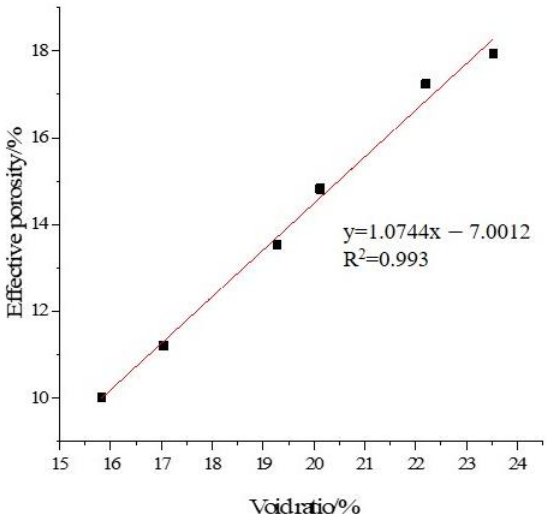
Figure 13. Void ratio versus effective void ratio.